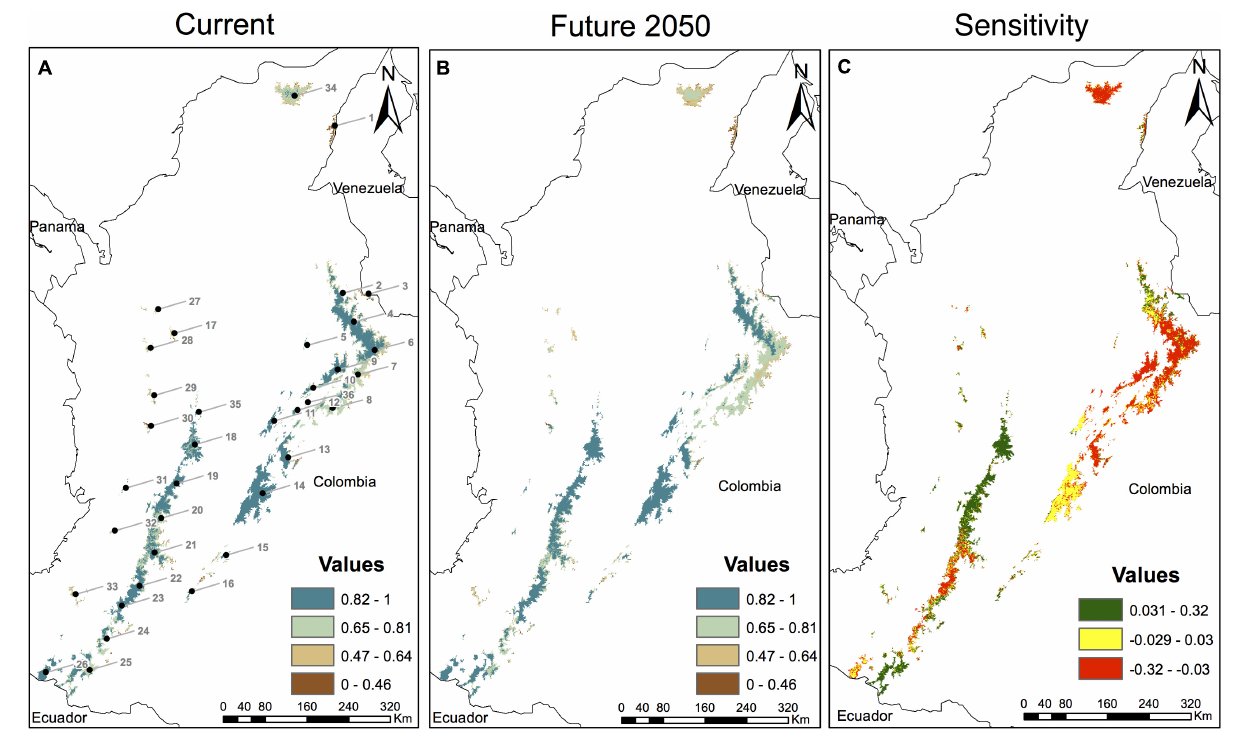
FIGURE 2 | Climate sensitivity estimates of Espeletia across 36 Páramo complexes in the Colombian Andes. Climate sensitivity was modeled by comparing (A) current (baseline period 1970–2000) and (B) future (2050 RCP 8.5) average distribution probabilities across 28 taxa, as obtained with Maxent v. 3.4.1 (Phillips et al., 2017) under a niche conservatism scenario (i.e., range shift via migration). Values close to zero in the sensitivity index (C) indicate few changes in the forecasted distribution of Espeletia due to climate change, while negative and positive values correspond to range losses and gains, respectively, based on the averaged presence probabilities. Five non-collinear WorldClim bioclimatic variables ( Supplementary Table S3 ) were considered at a 30 s (1 km 2 ) spatial resolution for the current and future scenarios, besides a Digital Elevation Model (DEM). Espeletia taxonomy follows Cuatrecasas (2013). Páramo complexes are numbered in (A) according to Morales et al. (2007) and Londoño et al. (2014), specifically: (1) Perijá, (2) Jurisdicciones-Santurbán, (3) Tamá, (4) Almorzadero, (5) Yariguíes, (6) Cocuy, (7) Pisba, (8) Tota-Bijagual-Mamapacha, (9) Guantiva-Rusia, (10) Iguaque-Merchán, (11) Guerrero, (12) Rabanal y río Bogotá, (13) Chingaza, (14)